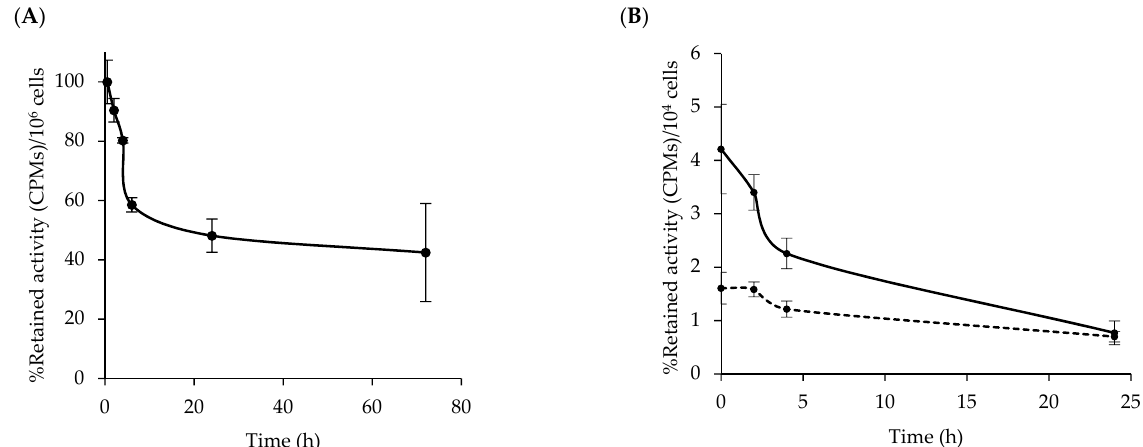
Figure 5. Efflux of [ 64 Cu]Cu-NOTA-C3-TP from the HCT116 cells. ( A ) Efflux is expressed as the percentage of retained [ 64 Cu]Cu-NOTA-C3-TP activity at t = 0, where the radioactive media was removed. Data are presented as total activity (%)/10 6 cells. ( B ) Displacement of [ 64 Cu]Cu-NOTA-C3-TP by excess of 100 µM (solid line) or 500 µM (dotted line) of [ Nat Cu]Cu-NOTA-C3-TP in the HCT116 cells over a 24 h time course. The ratios are expressed as the percentage of retained activity per initial loaded activity.